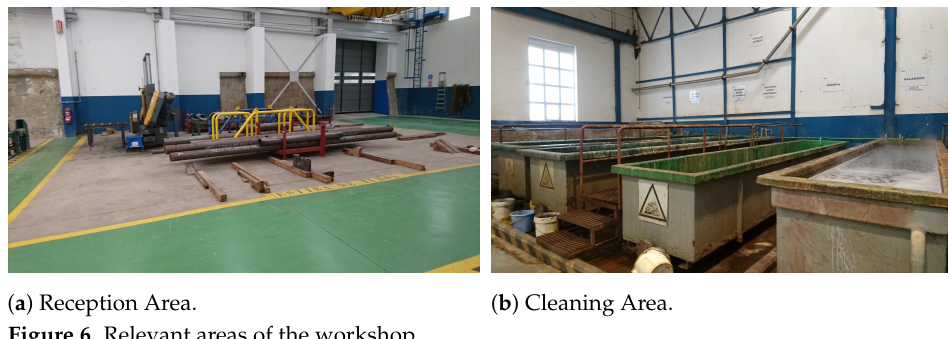
Figure 6. Relevant areas of the workshop.